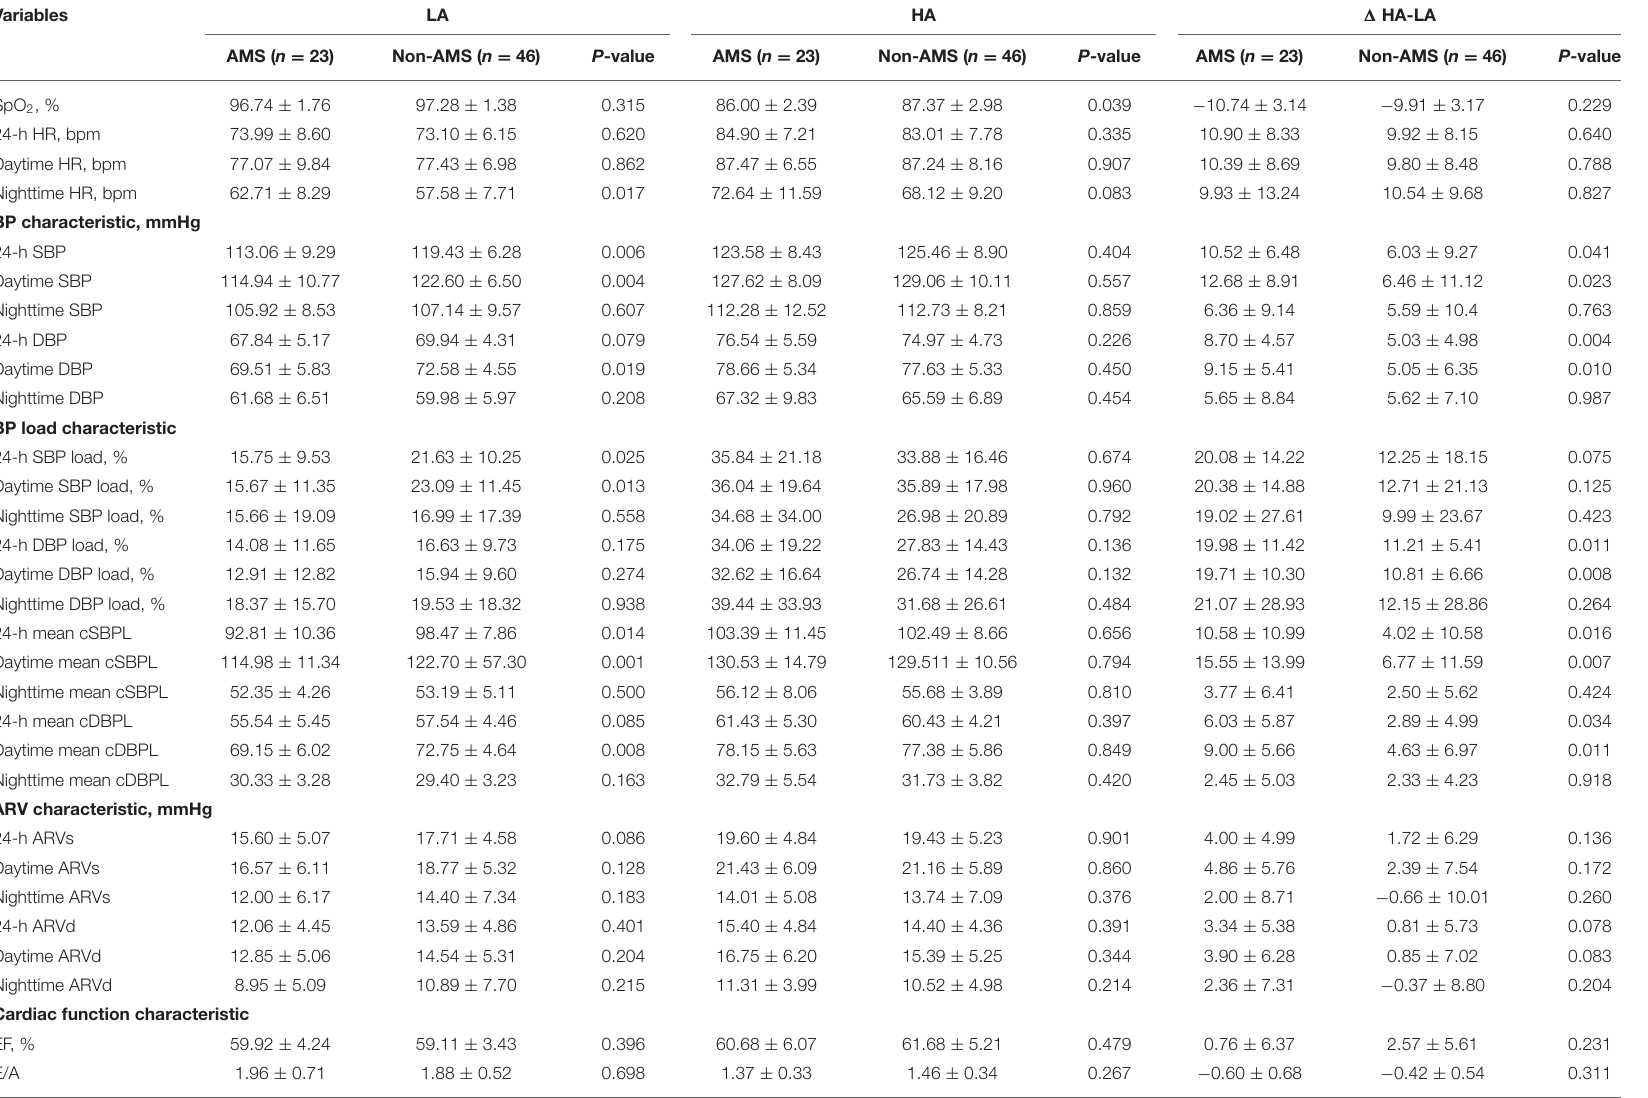
TABLE 2 | Effect of acute HA